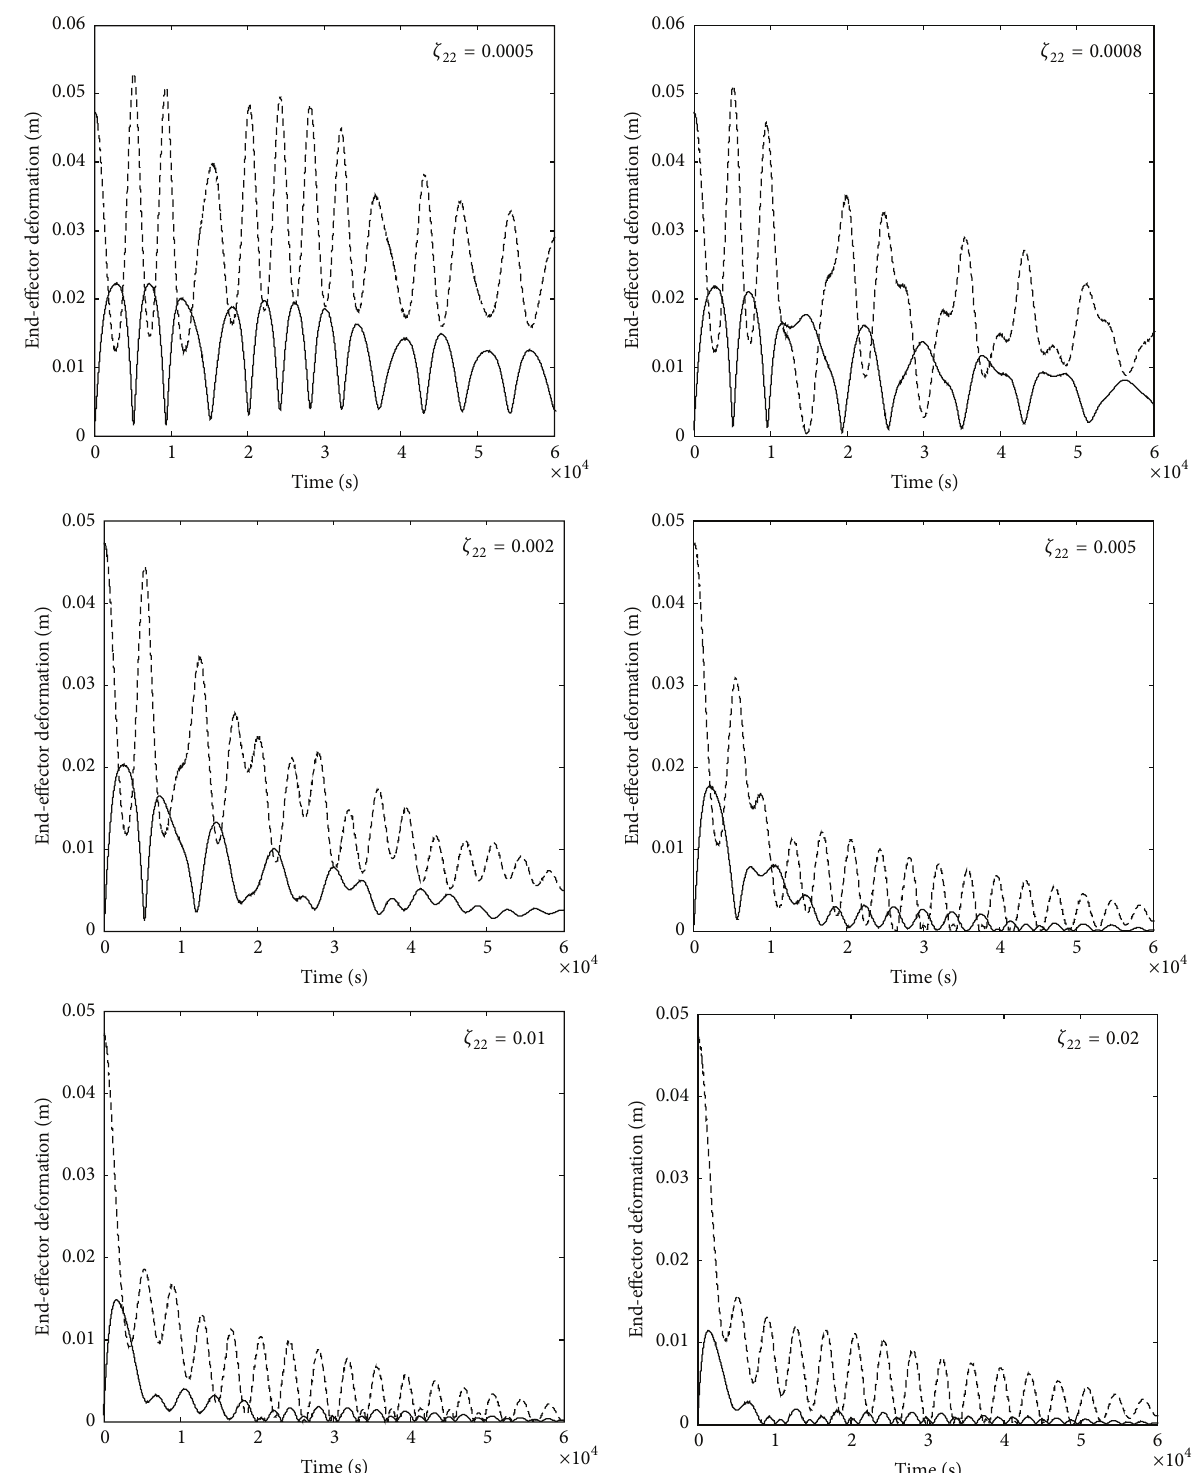
Figure 14: Effects of the absorber